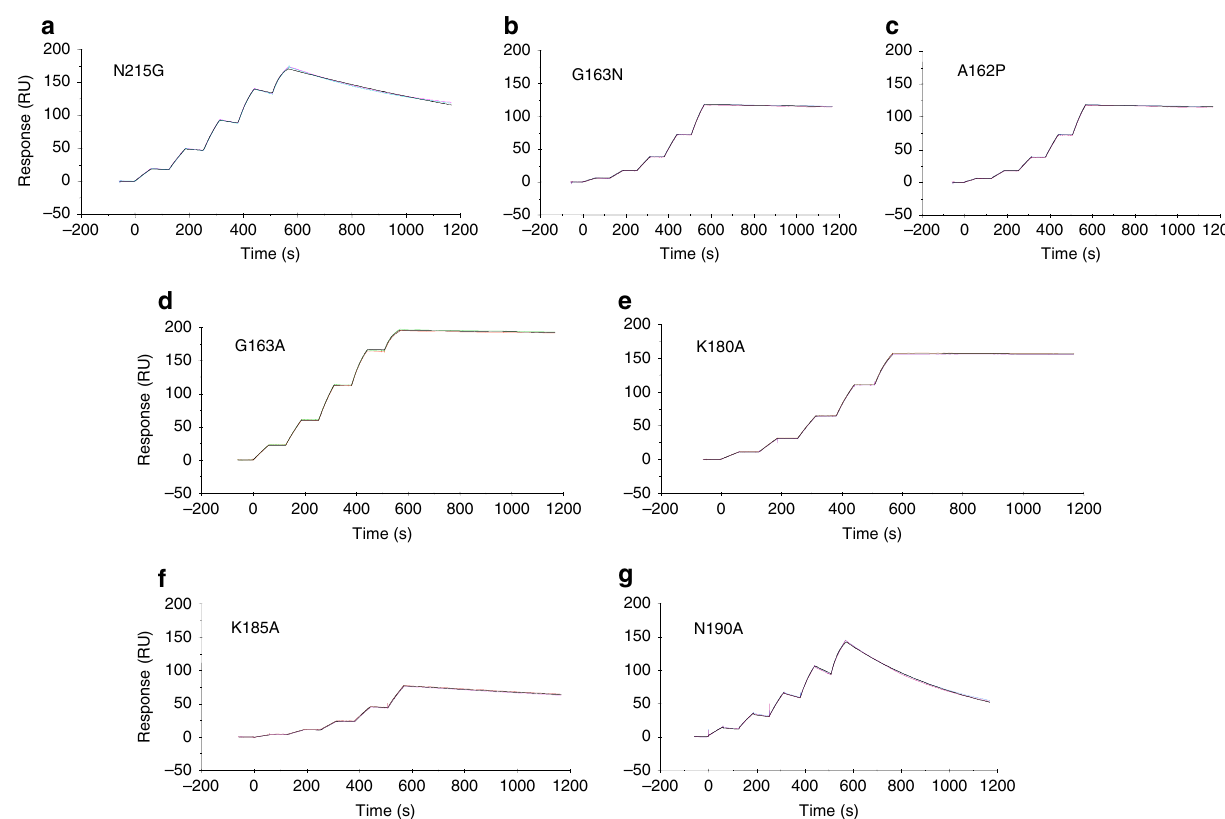
Fig. 6 Impact of fHbp var1.1 site-speci fi c mutations on the binding to mAb 1A12. The effect of the mutations was analyzed by SPR with mAb 1A12 captured on the surface, and the association and the dissociation of diverse mutants (panels a - g ) were monitored in duplicate (colored traces). The single-cycle kinetics fi tting (Langmuir 1:1 model) is represented as solid black lines in each sensorgram (full details of kinetic analyses are provided in Methods